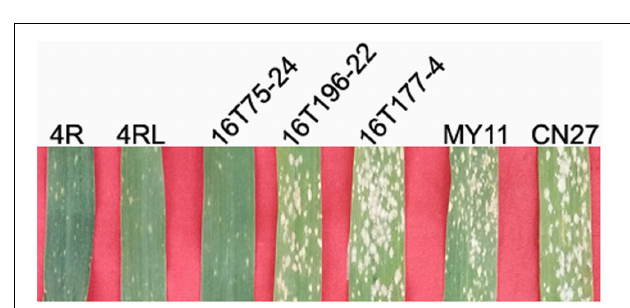
FIGURE 6 | Powdery mildew resistance testing. MY11, CN27, line 16T177-4 and line 16T196-22 are highly susceptible to powdery mildew. Lines MA4R Ku , MTA4RL Ku , 16T75-24 are highly resistant to powdery